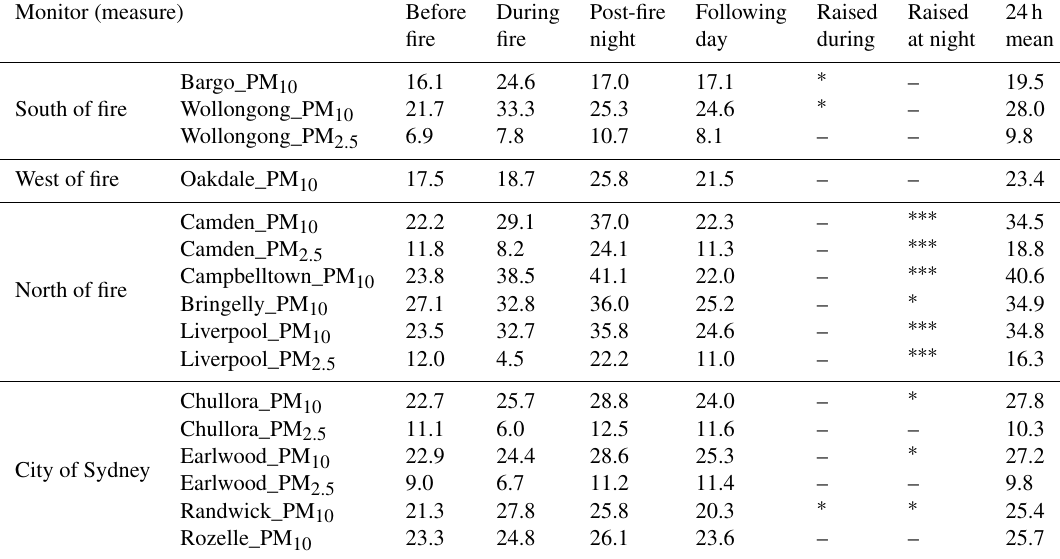
Table 2. Summary of particulate observations from the permanent air quality network. The data are the mean values in four periods: before the 700ha fire (midnight 9 October 2015 – 10:00), during the fire (10:00–18:00), during the night (18:00–06:00 10 October 2015) and the following day (10:00–18:00). “Raised during” and “Raised at night” report ANOVA tests comparing two particular periods to all the others. P values are reported ( ∗ : p < 0.05, ∗∗∗ : p < 0.001).